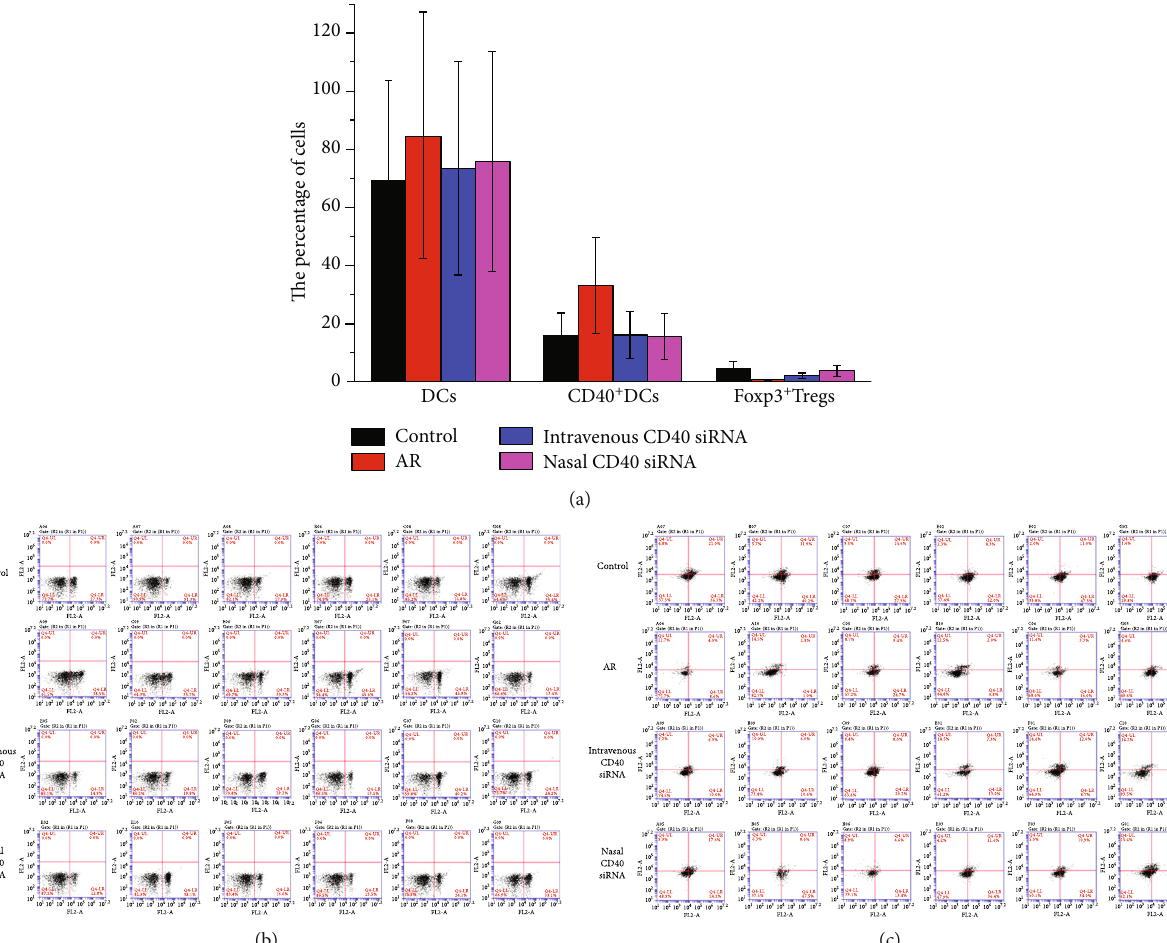
Figure 3: (a) CD40 + DCs and Foxp3 + Tregs of the spleen in control, AR, intravenous CD40 siRNA, and nasal CD40 siRNA groups were detected by fl ow cytometry. CD40 expression on DCs in AR mice was higher than control group. There was no di ff erence between AR and siRNA groups. CD40 siRNA treatment resulted in inhibition of CD40 expression on DCs. There was no signi fi cant di ff erence between intravenous and nasal siRNA group. AR mice shown signi fi cantly less Foxp3 + Tregs, compared with control mice. Mice nasally treated with CD40 siRNA had signi fi cantly more Foxp3 + Tregs, compared with AR mice. There was no signi fi cant di ff erence between intravenous CD40 siRNA and AR group. P values < 0.05 were considered as signi fi cance. (b) CD40 + DCs of the spleen in control, AR, intravenous CD40 siRNA, and nasal CD40 siRNA groups were detected by fl ow cytometry. (c) Foxp3 + Tregs of the spleen in control, AR, intravenous CD40 siRNA, and nasal CD40 siRNA groups were detected by fl ow